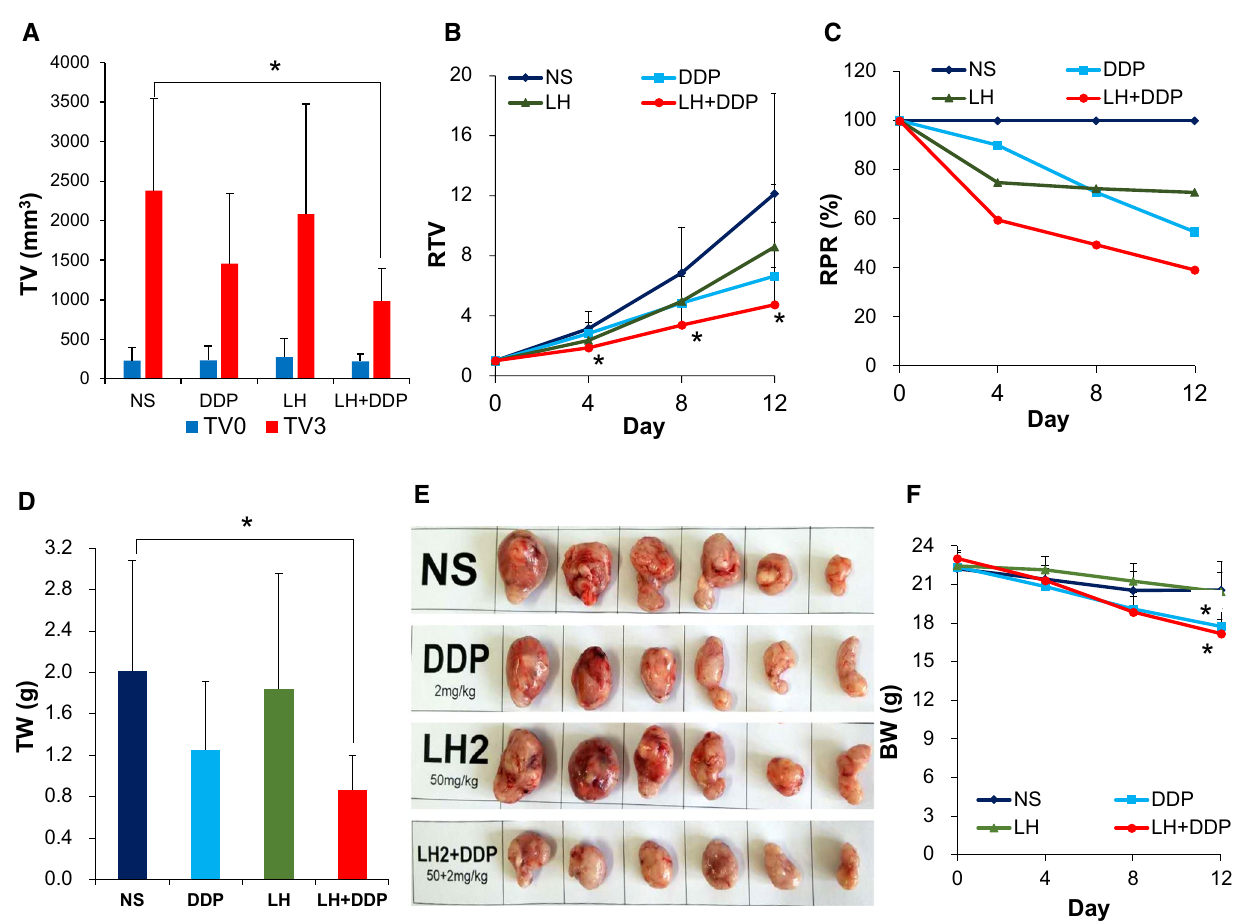
Fig. 4 Effects of levofloxacin, cisplatin and their combination on the tumor growth in xenograft mouse model. A Tumor volume before drug administration (TV0) and at the end of the study (TV3). B RTV throughout the study. C RPR throughout the study. D TW at the end of the study. E The ex vivo tumor photos in different groups. F BW throughout the study. Data are mean ± SD from 6 mice [13]. Compared with NS group: * p <